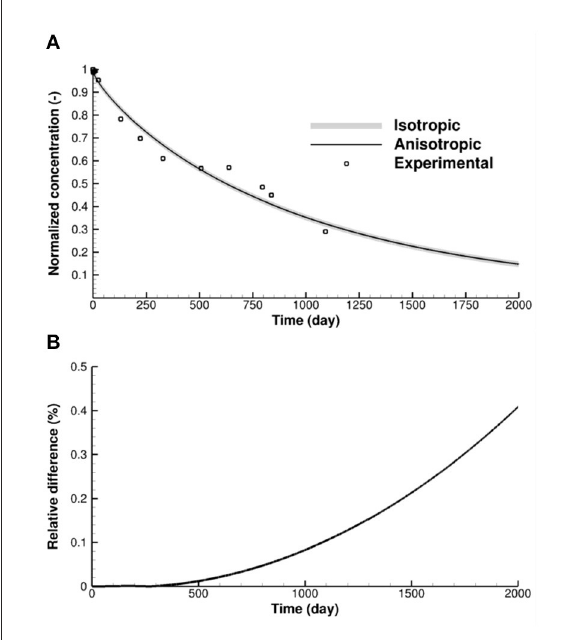
FIGURE8 (A) Comparison of normalized concentrations of HTO in the source reservoir for the anisotropic diffusion scenario, equivalent isotropic diffusion scenario and experimental observations, (B) relative difference of simulated reservoir concentrations between anisotropic and equivalent isotropic diffusion